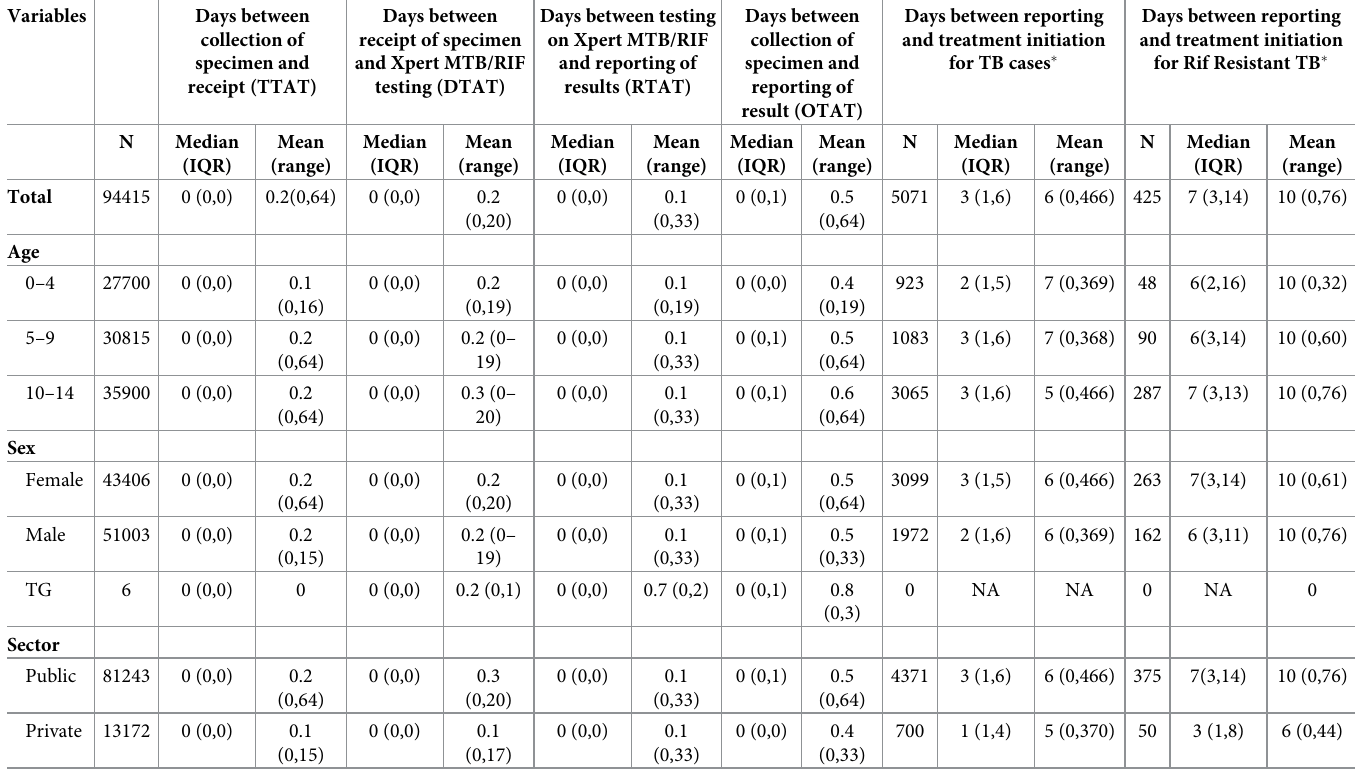
Table 2. Project turnaround time: Time between events in the diagnostic